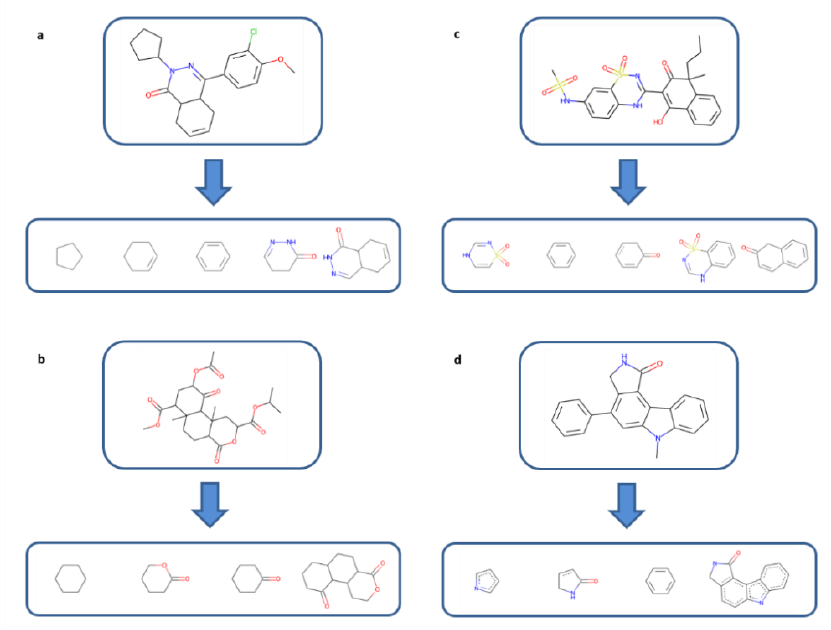
Figure 2. Generation of ring fragments: ( a , b ) illustrate the generation of chemically intact rings, and ( c , d ) the extraction of ring fragments from fused rings with retained hybridization states, making it possible to detect such model fragments in complex ring systems of test com- pounds.